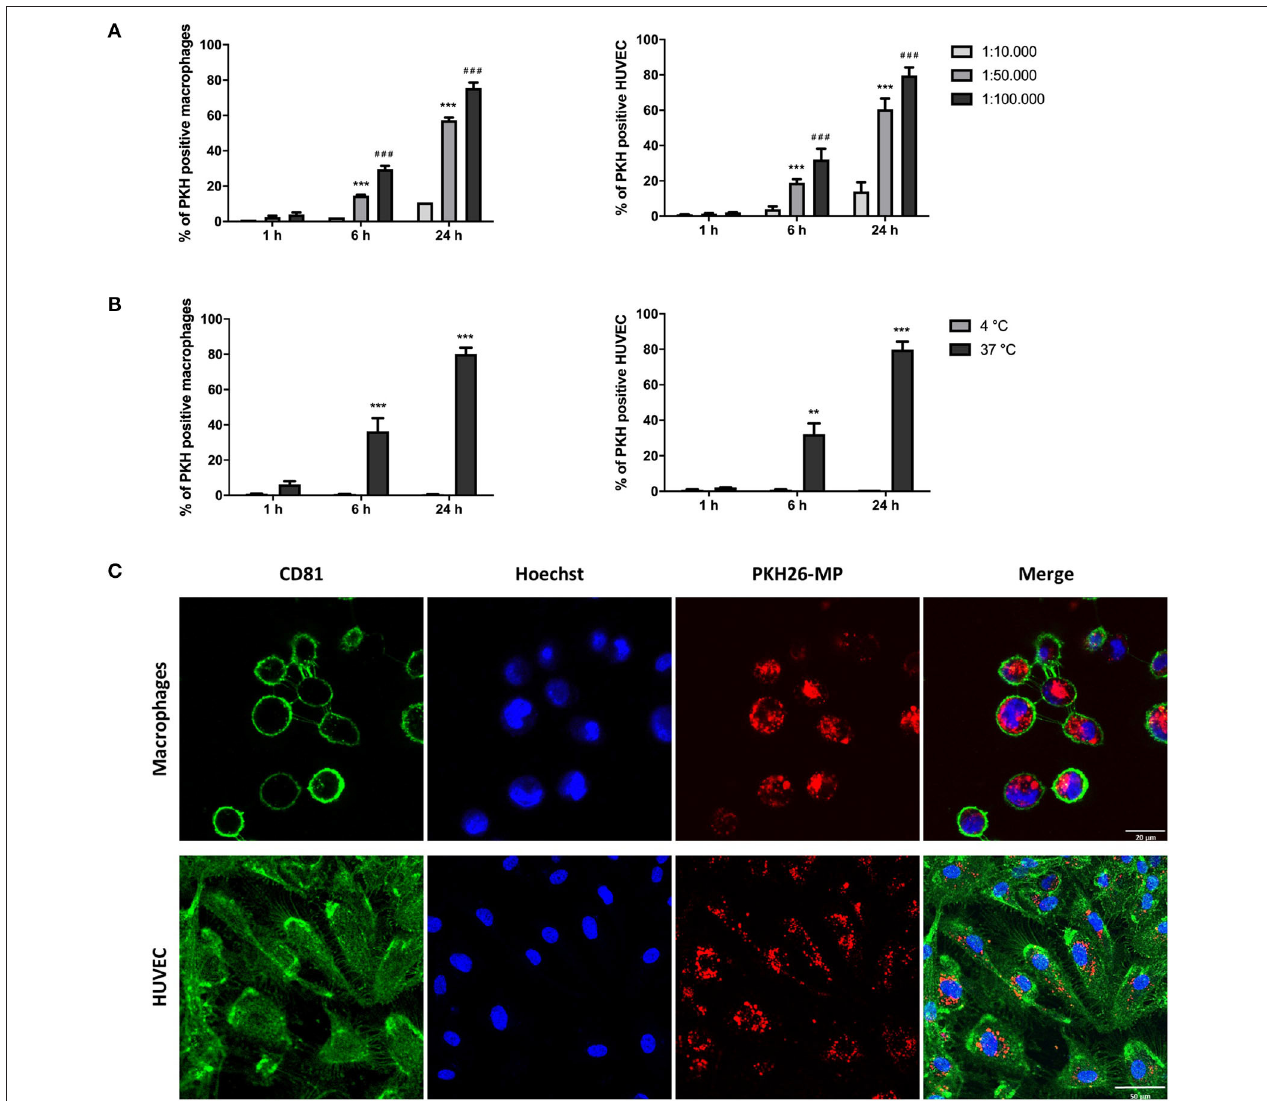
FIGURE 2 | Macrophages and HUVEC internalize MP in a dose-, time-, and temperature-dependent manner. MSC were labeled with PKH-26 before the generation of MP (PKH-MP). PKH-MP were added to macrophages or HUVEC (ratios 1:10,000, 1:50,000, 1:100,000), incubated for 1, 6, and 24h at 4 or 37 ◦ C, and analyzed by flow cytometer or confocal microscopy. (A) Percentage of macrophages and HUVEC positive for PKH-MP in different doses of MP over time, and (B) at 4 and 37 ◦ C over time. (C) Representative confocal microscopy analysis of MP uptake by macrophages and HUVEC (ratio 1:50,000) at time point 24h. Staining for CD81 cell membrane (green), Hoechst 33,342 nucleus (blue), and PKH26-MP (red) demonstrated that MP are internalized by macrophages and HUVEC. Data are presented as mean ± SD from 3 to 4 experiments. *** P < 0.001 vs. ratio 1:10,000 and ### P < 0.001 vs. ratio 1:50,000 in (A) ; ** P < 0.001 and ** P < 0.001 vs. 4 ◦ C in (B) . Scale bars: 20 µ m (macrophages) and 50 µ m